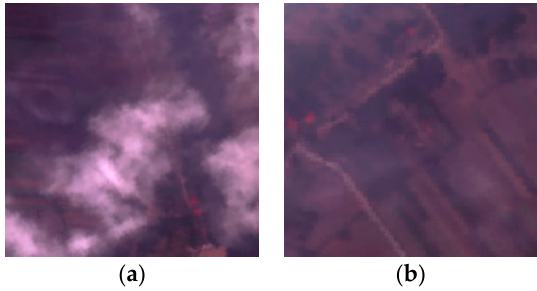
Figure 1. Clouds on Gao Fen-1(GF-1) images: ( a ) thin clouds and ( b ) very thin clouds.